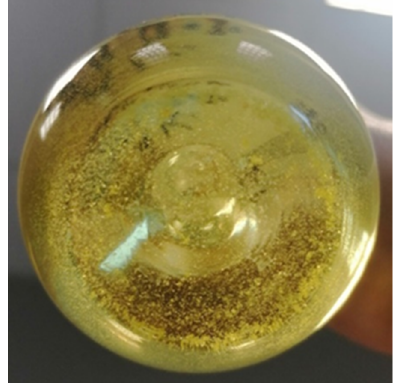
Figure 4. Solution A1—the view of the bottom of the glass vessel with the crystal, yellow sediment on the 14th day of observation.